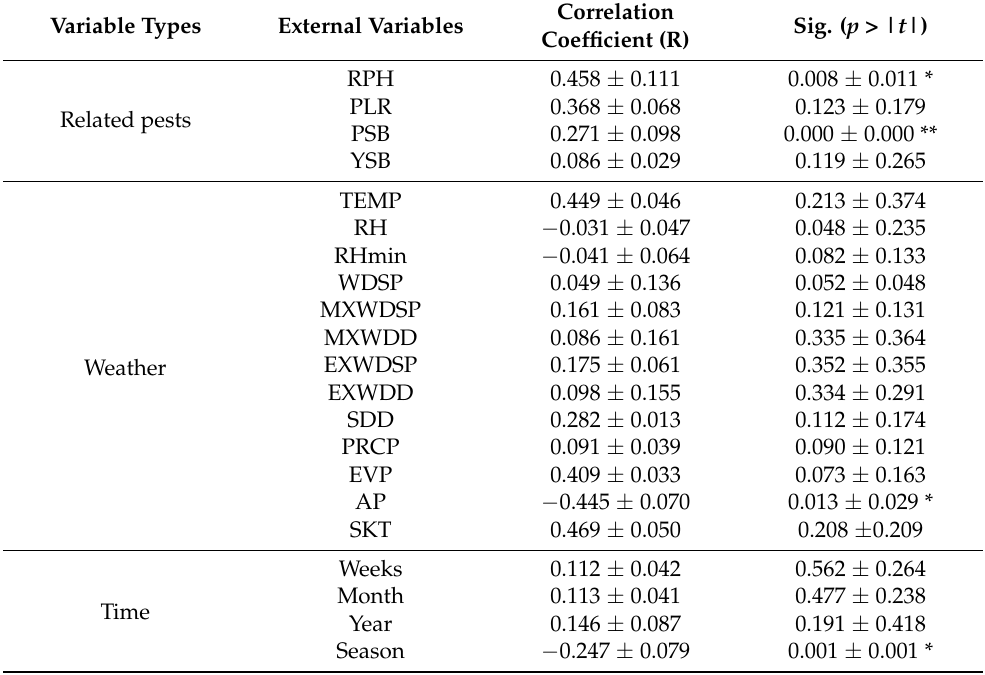
Table 6. Pearson’s correlation coefficient (R) between the natural log-transformed SRSB light trap catch and its associated pest, meteorological, and time features from March to October in the rice crop season.